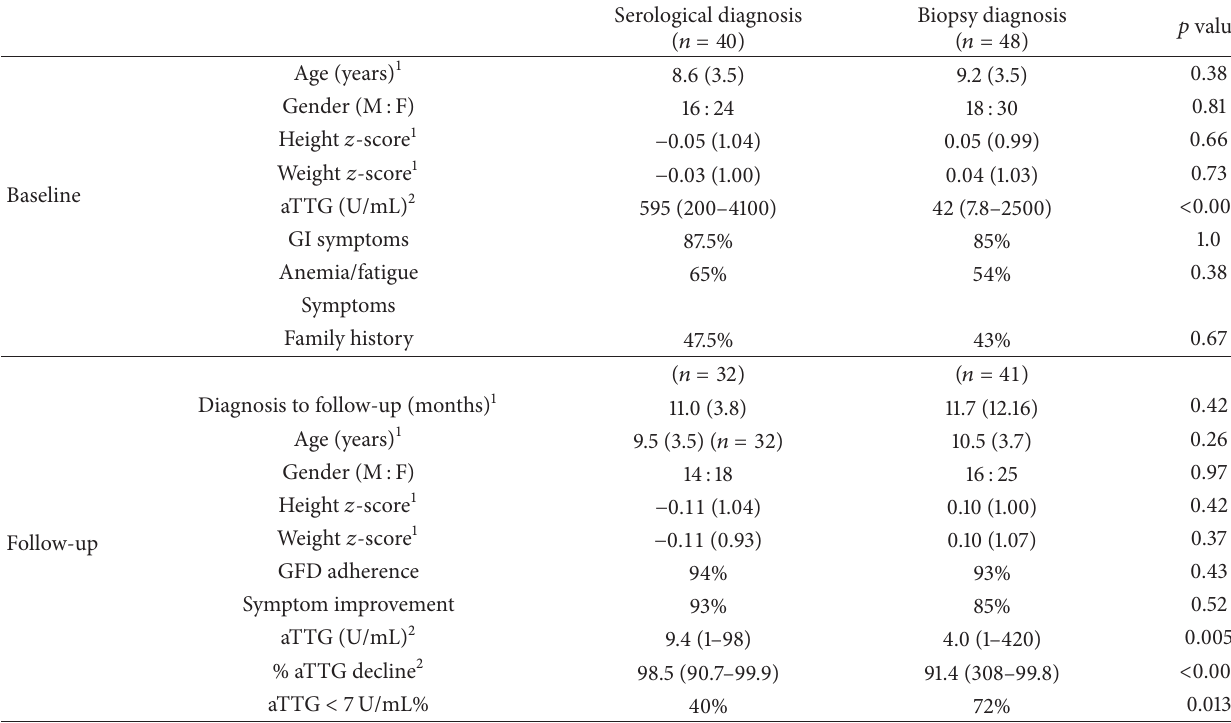
Table 1: Baseline and follow-up comparisons between diagnostic groups. Serological diagnosis